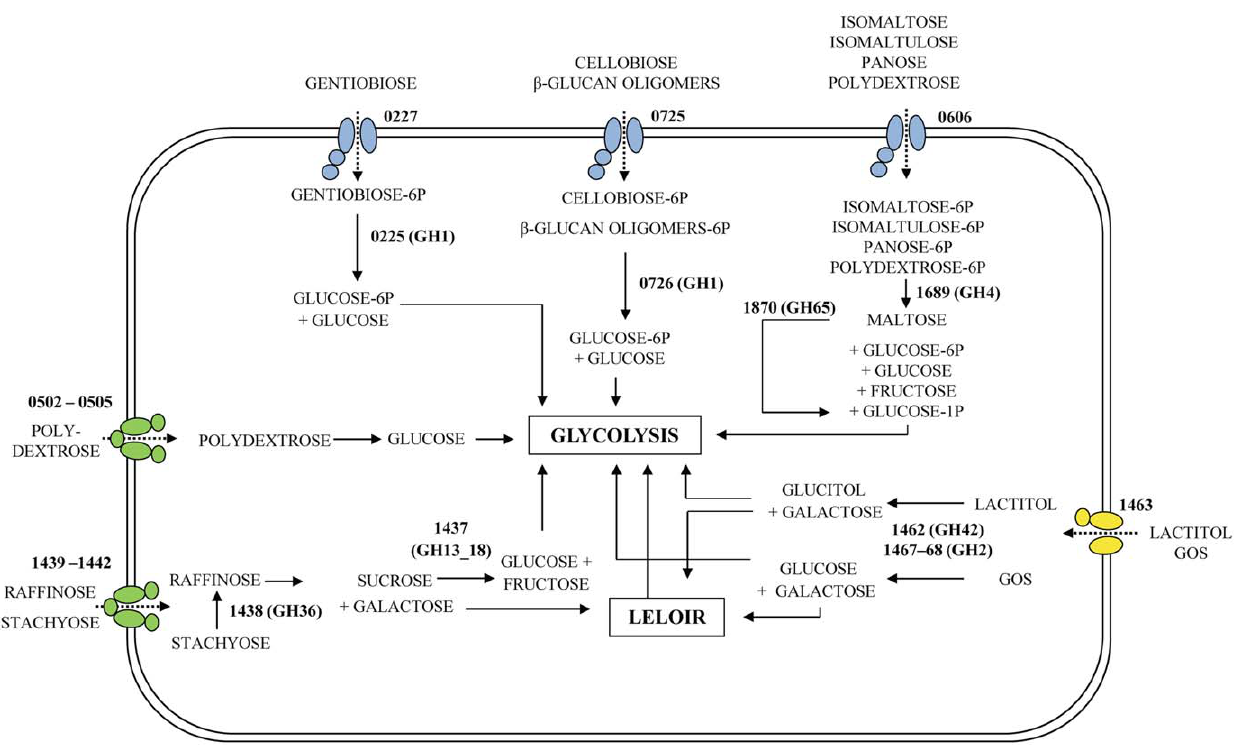
Figure 4. Reconstructed uptake and catabolic pathways in L.acidophilus NCFM. Proteins are listed by locus tag LBA numbers, transporters are colored by class (Figure 3) and glycoside hydrolases are listed with GH family number. The polydextrose fraction transported by the ABC transporter (LBA0502–LBA0505) is uncertain and thus the hydrolytic pathway is marked as unknown. The present data outlines the PTS permease LBA0606 (higher level of induction compared to LBA0502–LBA0505) and associated hydrolytic pathway, as the main route of polydextrose utilization by L. acidophilus NCFM.